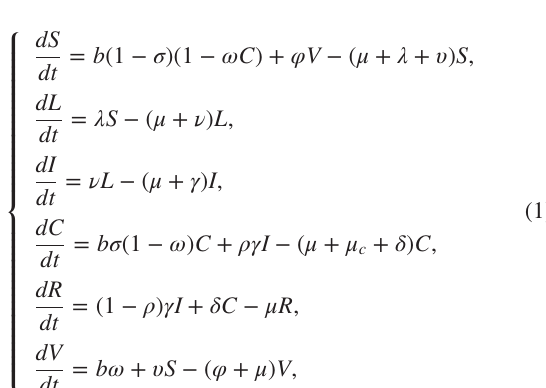
Figure 1. Flowchart of the search